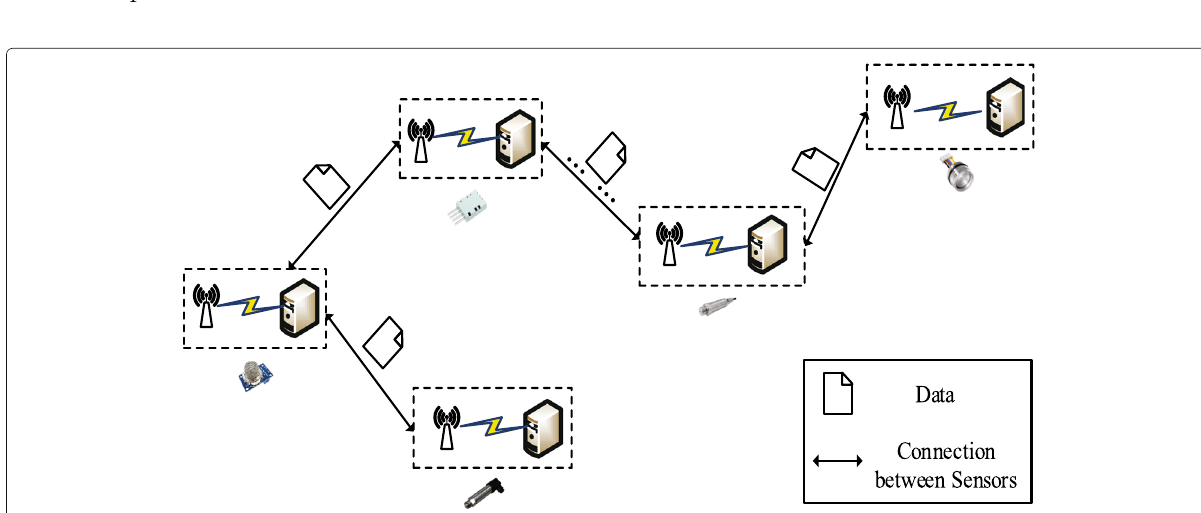
Fig. 1 A framework of data offloading for intelligent sensors in edge